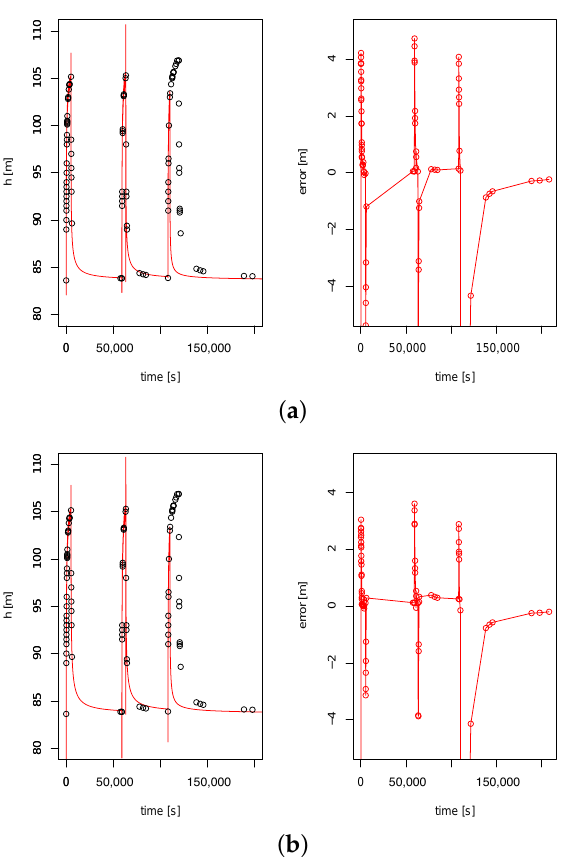
Figure 11. Validation. ( a ) Left, water level evolution, measured (black) and simulated (red) with the 1st set of parameters (updated). Right, error estimation evolution. ( b ) Same results as ( a ) with the 2nd set of parameters (updated).